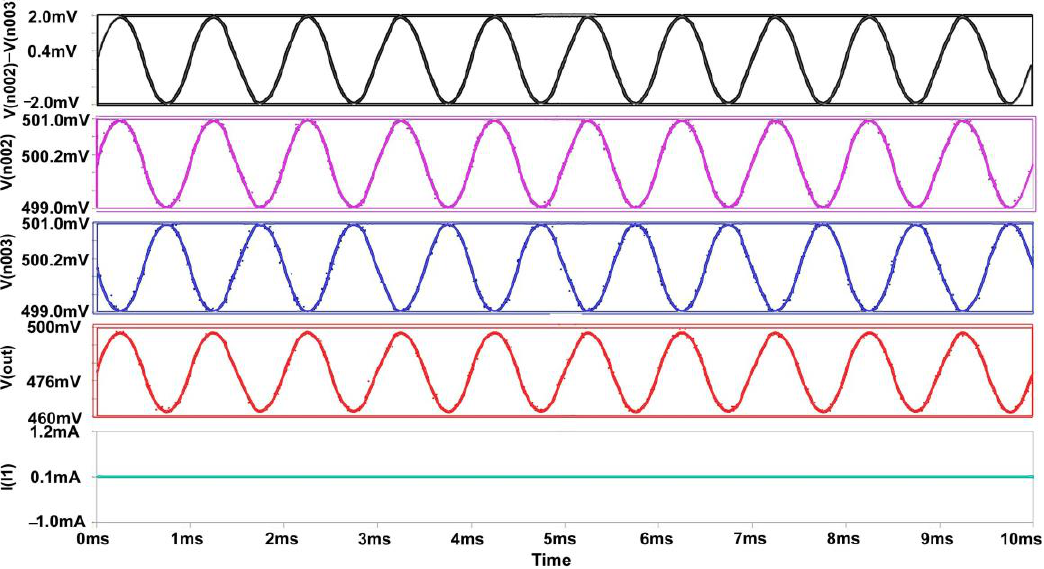
Figure 5. Output waveform of Differential Voltage Sense Amplifier.